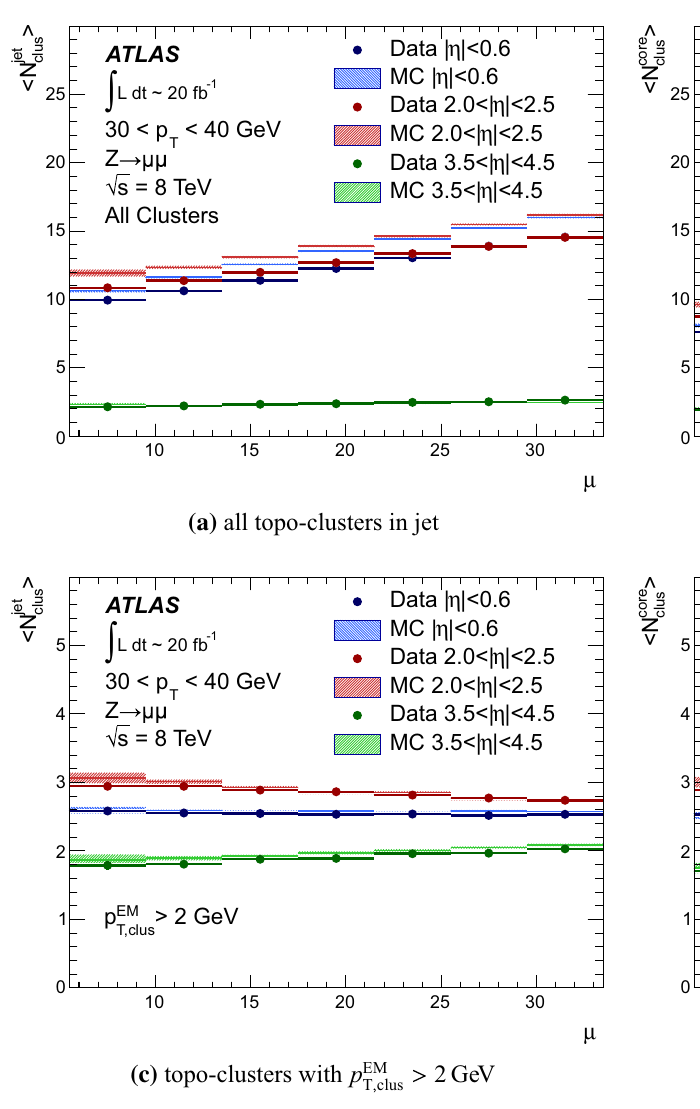
> 2GeV inside jets T , clus